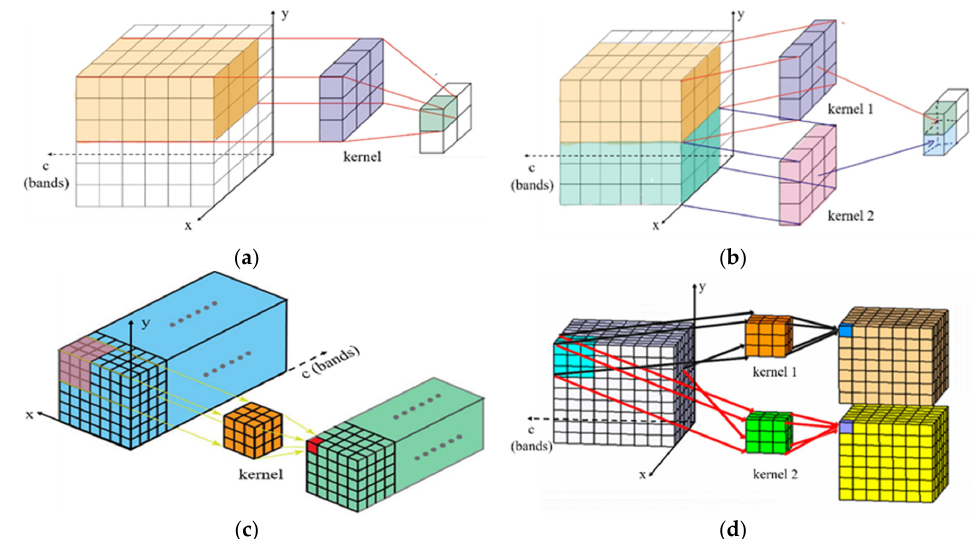
Figure A1. The difference between two-dimensional (2D) convolution and three-dimensional (3D) convolution; ( a ) 2D convolution extracted features; ( b ) 2D convolution with multiply kernels; ( c ) 3D convolution extracted features; ( d ) 3D convolution with multiply kernels.